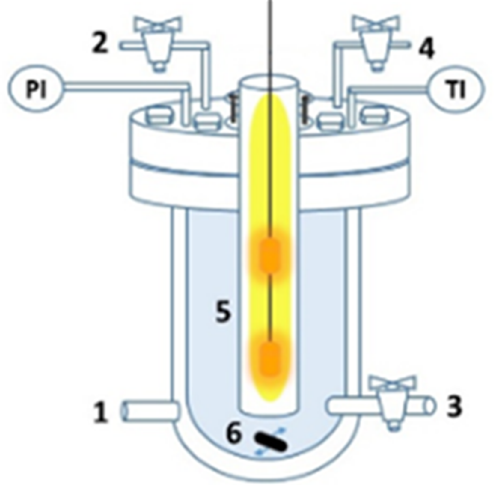
Figure 8. Sketch of the high-pressure photo-reactor, adapted and reproduced from [50]. (1) water colling system (2) gas inlet (3) liquid sampling port (4) gas sampling port/purge (5) quartz sleeve (6) magnetic stir bar